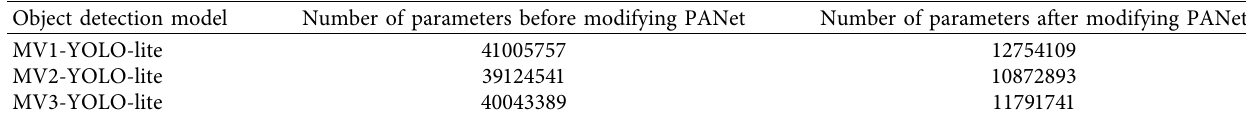
Table 1: Comparison of parameter numbers before and after PANet model